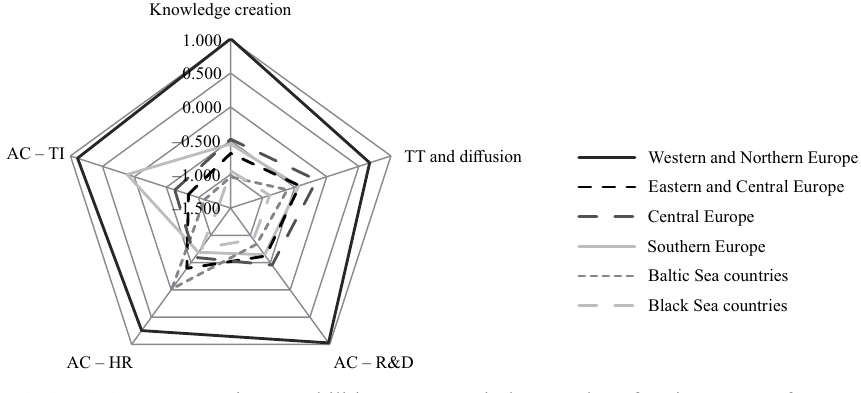
Fig. 3. 1998–2000 Innovation capabilities summary indexes values for six groups of countries Source : Own calculations based on data from sources indicated below Table 1.